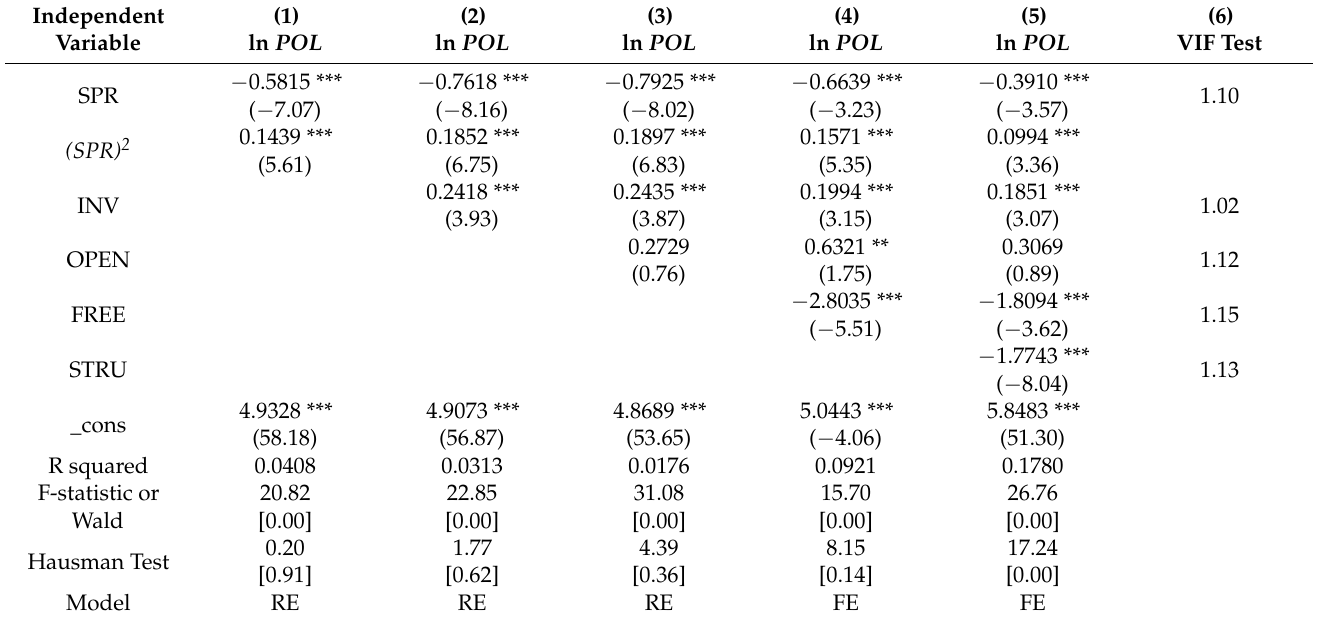
Table 4. Estimation results of the full